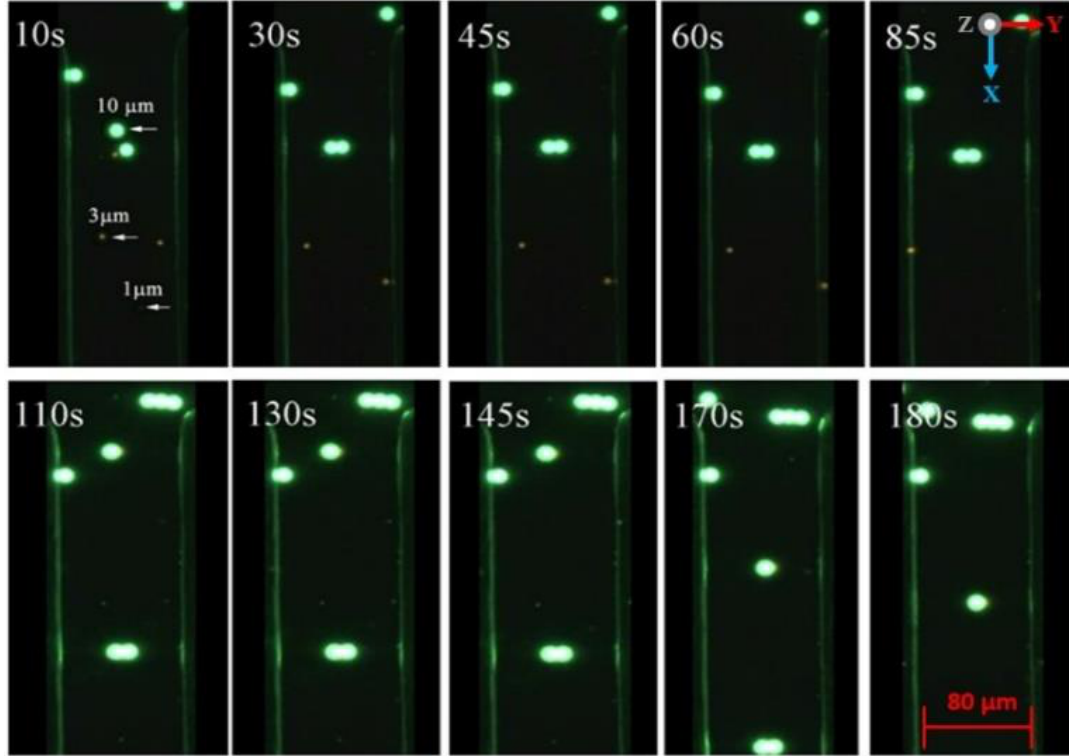
Figure 17. The sequencing of separation of 1 µ m, 3 µ m and 10 µ m Ps at two different locations. 1 µ m and 3 µ m Ps were at the top surface microelectrodes while 10 µ m Ps was between two microelectrodes.